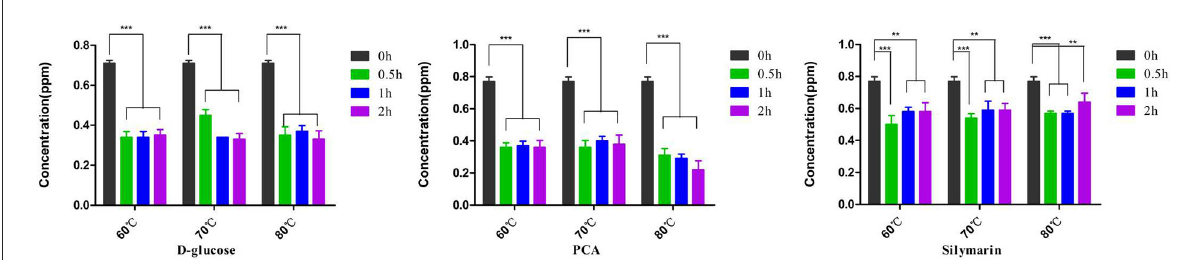
FIGURE1 Detoxification of D-glucose, PCA, and silymarin post treatment with diverse temperatures and different durations. D-glucose and PCA possessed highly degradation activities on FB1, while silymarin possessed a detoxifying activity on FB1 degradation. ** p < 0.01 and *** p < 0.001, D-glucose, PCA, and silymarin groups showed significant differences at 0.5–2h compared to the initial treatment at 0h. Regarding temperature on detoxification, the degrading effects of D-glucose and PCA were evident at 80 ◦ C for 2h. However, no statistical difference was found in the silymarin-treated group from 60 to 80 ◦ C.